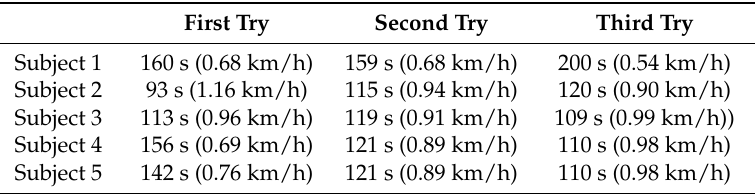
Table 4. Results of the second walking test (time and